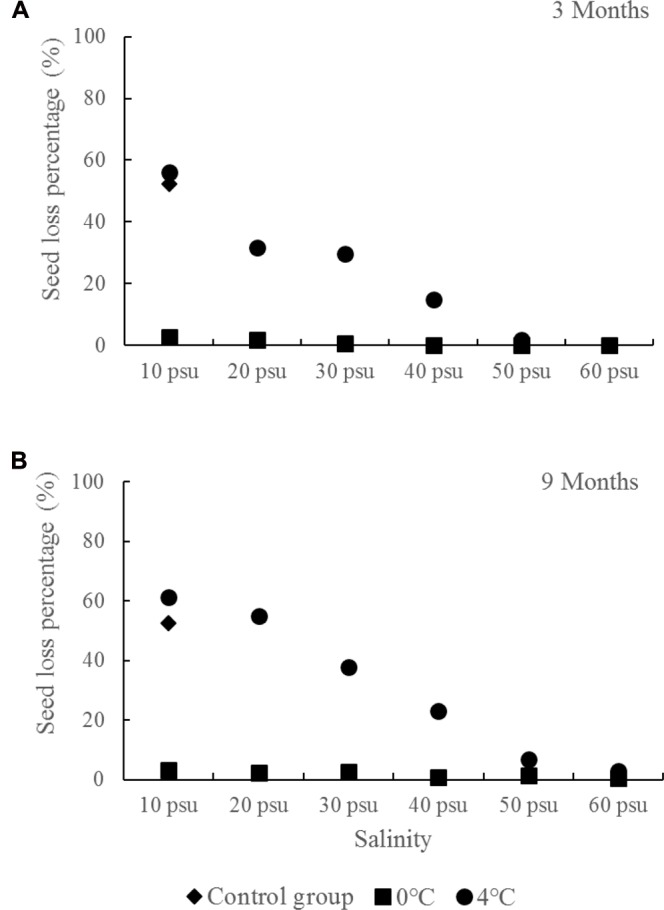
Ruppia sinensis seed losses under different salinity and temperature conditions in the long-term wet storage experiments (A, 3 months; B, 9 months). The control group was the seeds kept at a salinity of 10 psu and room temperature (10–25°C).